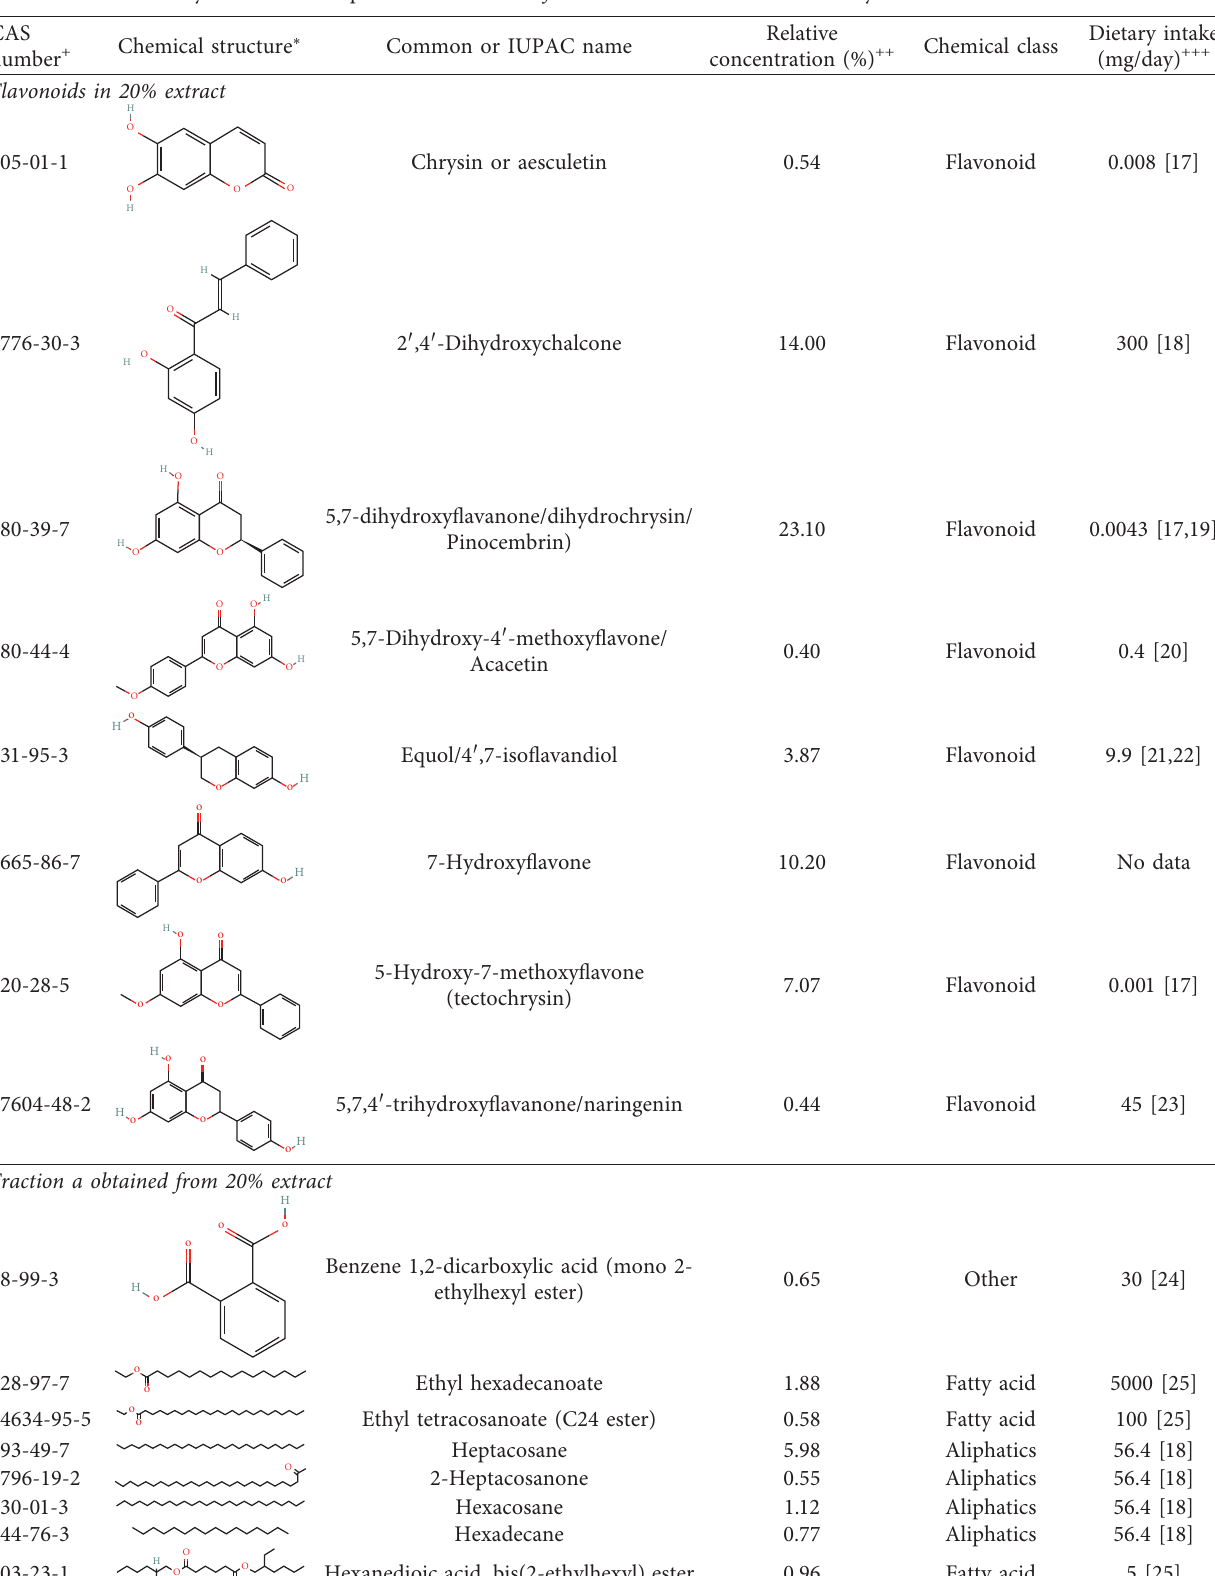
Table 1: Phytochemical composition of Galenia africana extract fractions and dietary risk intake risk in